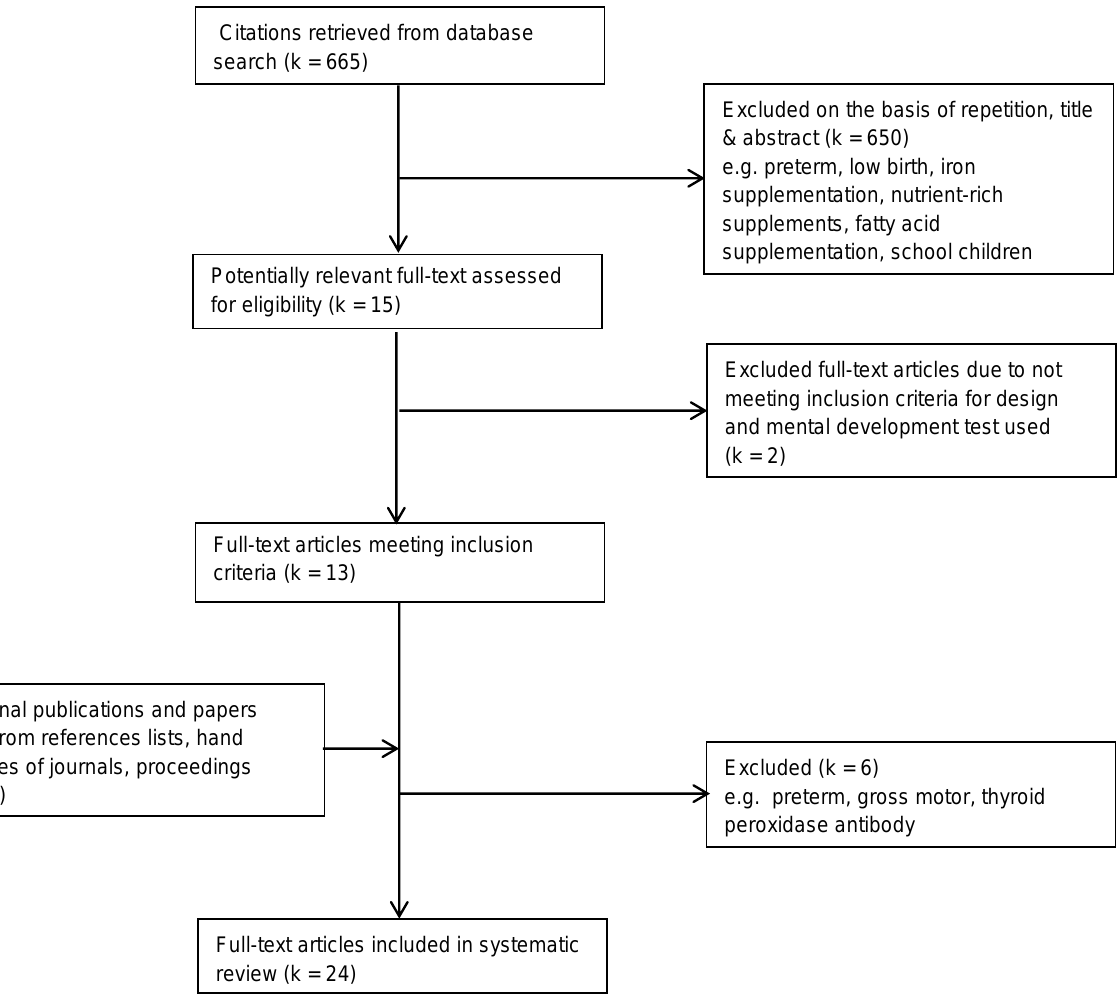
Figure 1. Selection of studies for systematic review of the effect of iodine on infant/child mental